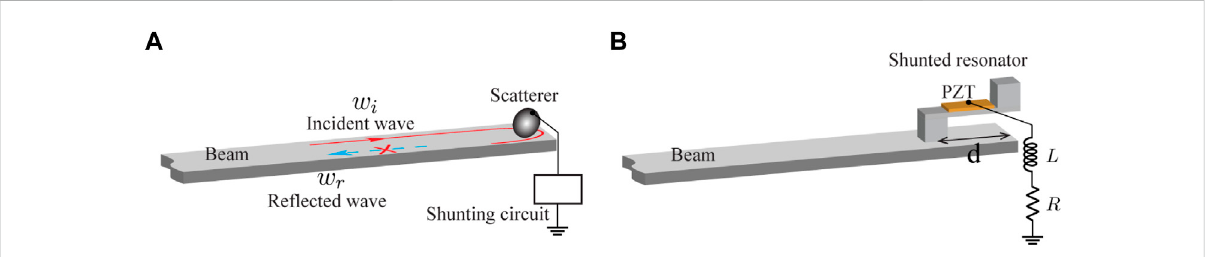
FIGURE 1 Design of an LR-shunted tunable perfect fl exural wave absorber. (A) Concept of a shunted scatterer for perfect fl exural wave absorption. (B) Schematic of an LR-shunted tunable perfect fl exural wave